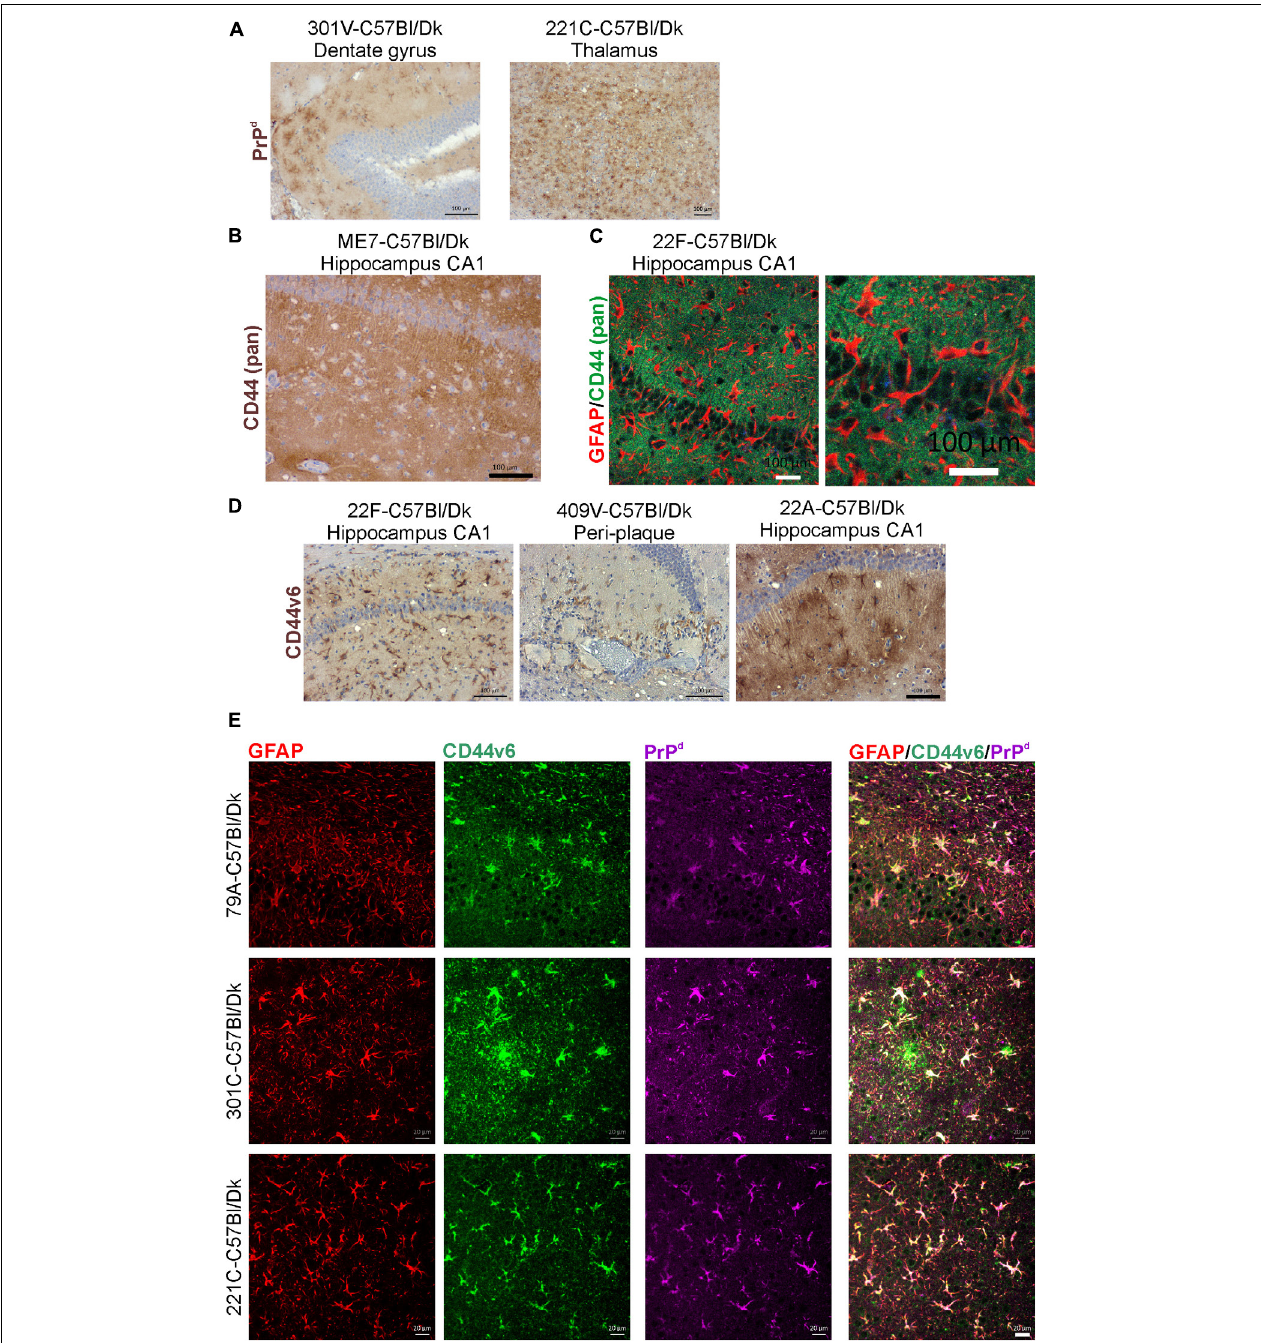
FIGURE 10 | CD44v6 expression and PrP d colocalize with GFAP + astrocytes in the brains during prion disease. (A) Immunohistochemical demonstration of astrocytic PrP d immunostaining patterns in brains of mice infected with certain prion agent strains. (B,C) Immunohistochemical analysis shows pan-CD44 expression surrounds but does not co-localize with GFAP in astrocytes. (D) Immunostaining for CD44v6 shows astrocytic staining pattern suggesting that astrocytes are the predominant cellular source of CD44 upregulation during prion disease. A–C scale bars = 100 µ m. (E) Immunofluorescent analysis of CD44, GFAP and PrP d in the brains of mice with prion disease shows that CD44 + /GFAP + astrocytes accumulate PrP d . Scale bars = 20 µ